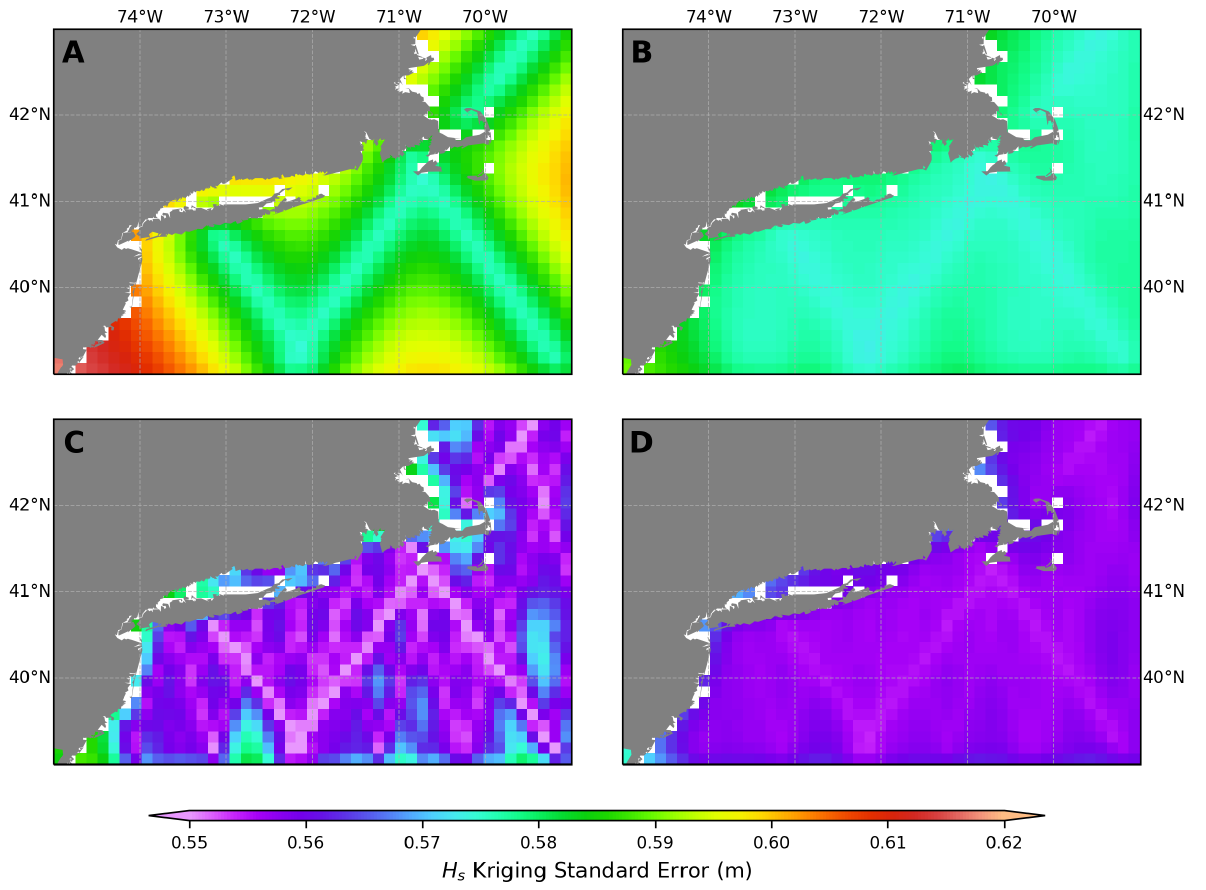
Figure 10. SWH Kriging standard error maps for the 2019 winter season using data from ( A ) Jason 3, ( B ) Jason 3 and SARAL/AltiKa, ( C ) Jason 3, SARAL/AltiKa, and Sentinel 3, and ( D ) all